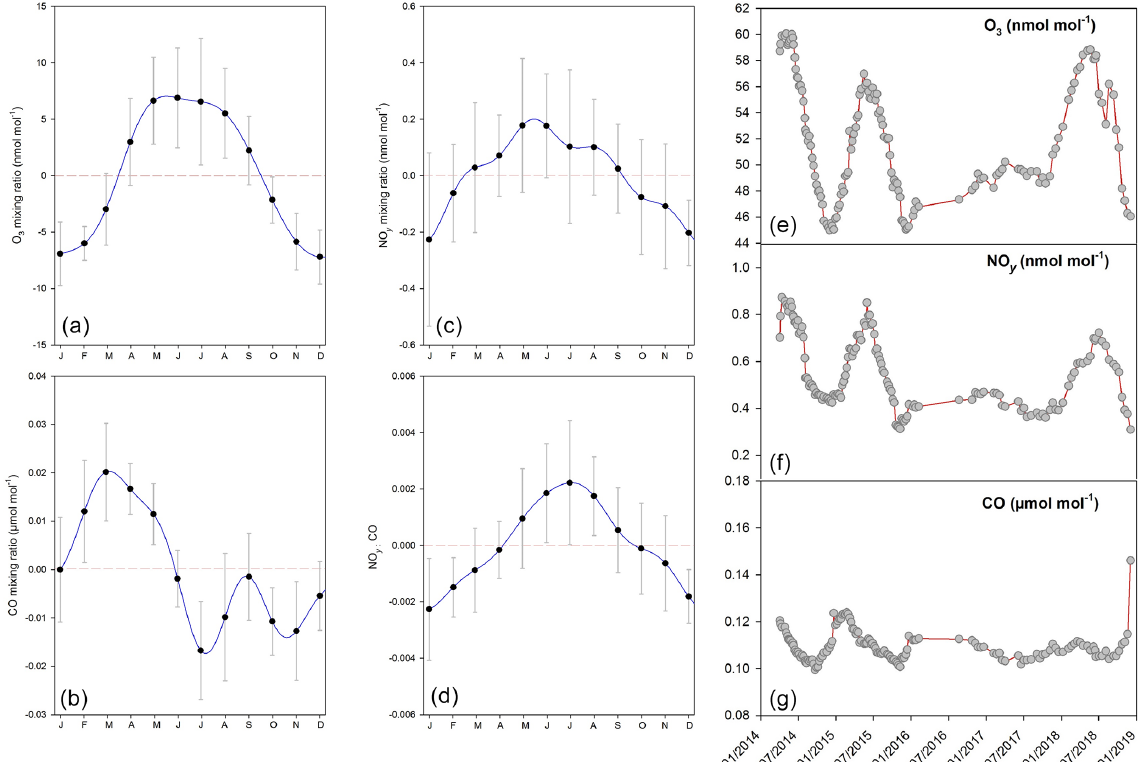
Figure 5. (a–d) Seasonality of in situ measurements of O 3 , NO y and CO mixing ratios and NO y / CO at Jungfraujoch; error bars represent the 1 standard deviation of monthly residuals from the NLS model simulation for time series. The 10min data were used for seasonality analysis. (e–g) In situ measurements of O 3 , NO y and CO mixing ratios were averaged over the exact period of discrete sampling ( ∼